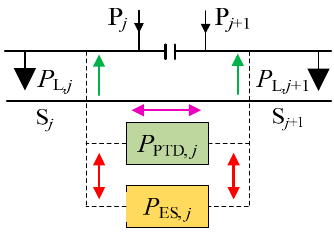
Figure 9. Power quality improvement by EPTD. Case 1: P L, j > 0, P L, j +1 > 0 No transmission. Case 2: P L, j ≤ 0, P L, j +1 ≤ 0 No transmission. Case 3: P L, j > 0, P L, j +1 < 0